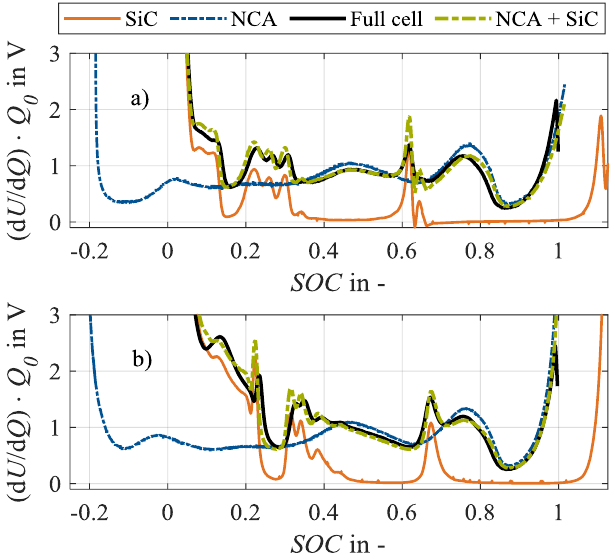
Figure 1. Spectra of differential voltage analysis (DVA) in ( a ) charge and ( b ) discharge direction of half cells (SiC, NCA; at approx. C/100), full cell in 18650 format (at C/30) and analytically reconstructed full cell (NCA + SiC) [34].